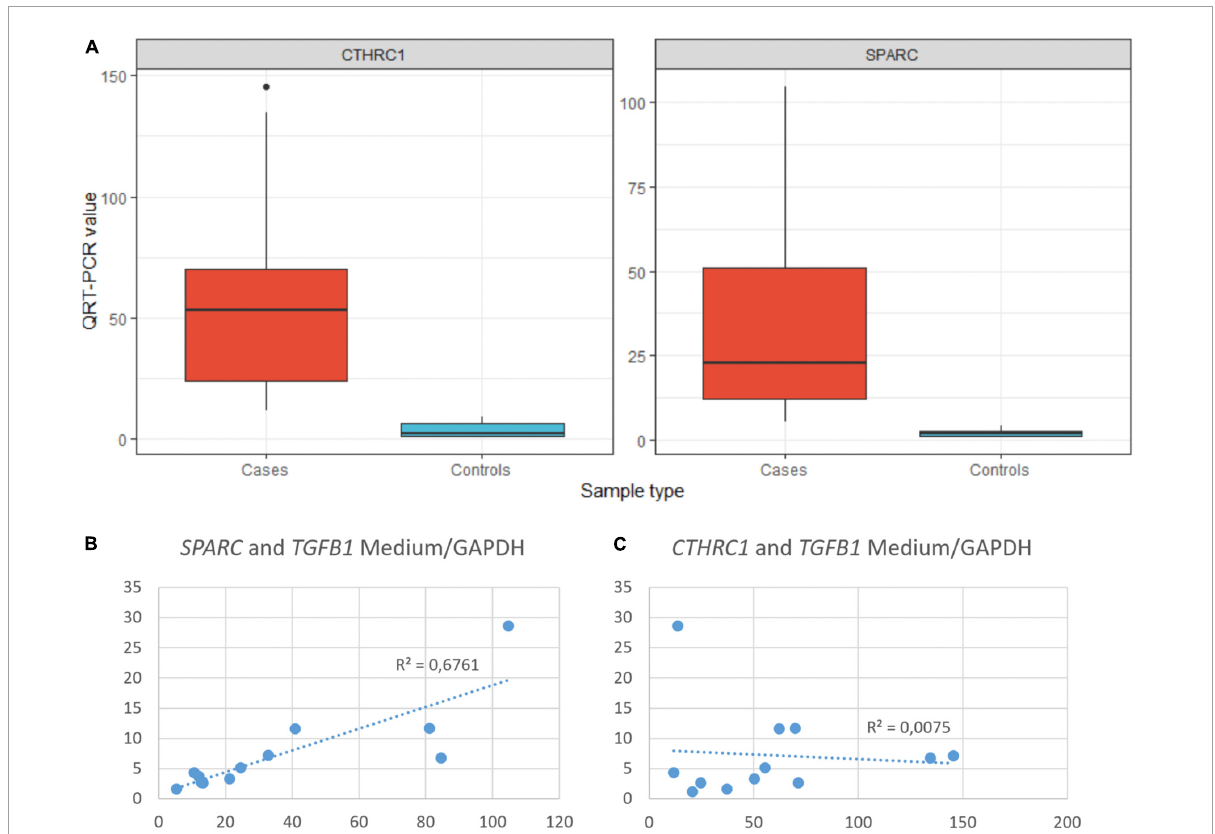
FIGURE6 (A) Statistical differences in the expression of CTHRC1 and SPARC between COVID-19 (cases) and normal (controls) samples. T -test: CTHRC1 p = 0.0012, SPARC p = 0.0054. QRT-PCR units: (cid:49)(cid:49) Ct. (B) Correlation between the expression of SPARC and TGF β 1 in COVID-19 samples. (C) Correlation between the expression of CTHRC1 and TGF β 1 in COVID-19